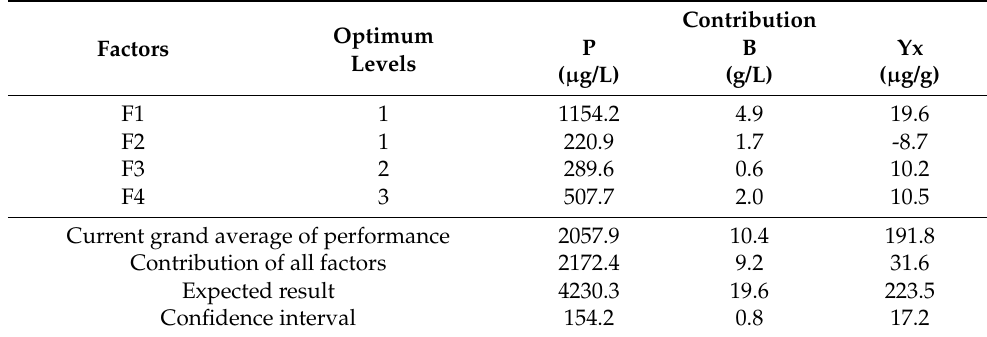
Table 4. Optimum levels and contribution of factors and expected results for the validation trial.